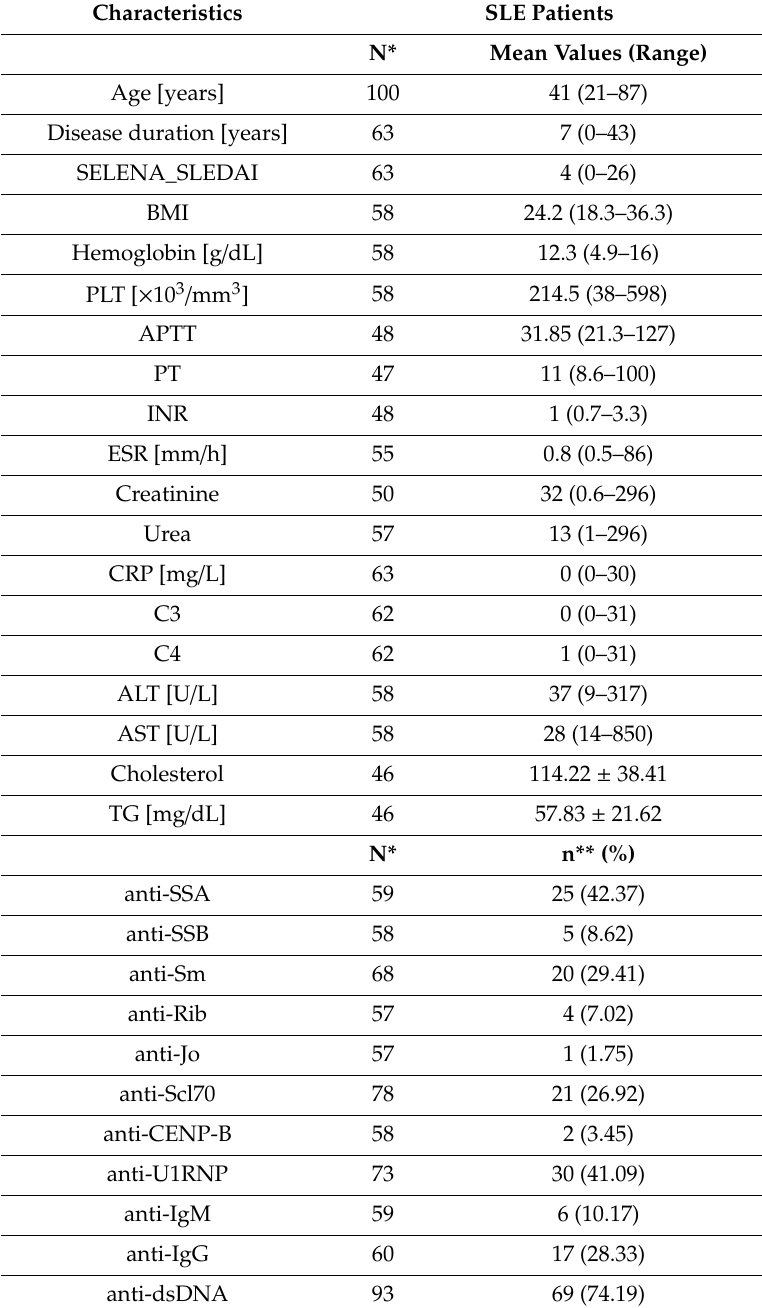
Table 1. Clinical characteristics of the study